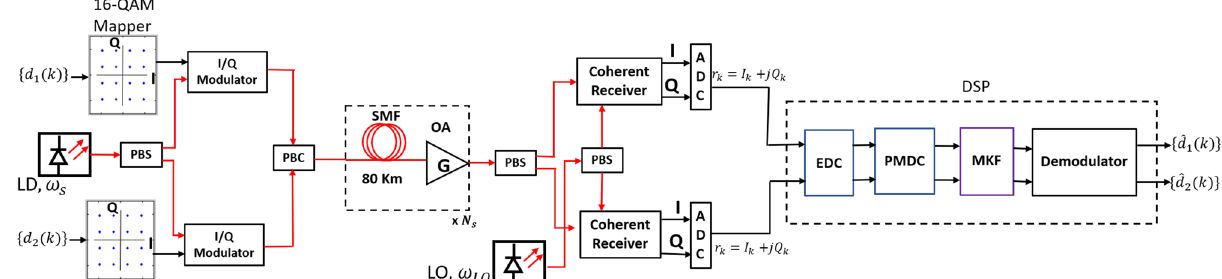
Figure 2. Simulation setup for 200 Gbps 16 QAM coherent optical communication system. SMF, single mode fiber; OA, optical amplifier; ADC, analog to digital convertor; EDC, electronic dispersion compensation; PMDC, polarisation mode dispersion compensation. PBS and PBC, polarisation beam splitter and combiner; MKF, multi-step Kalman filter.